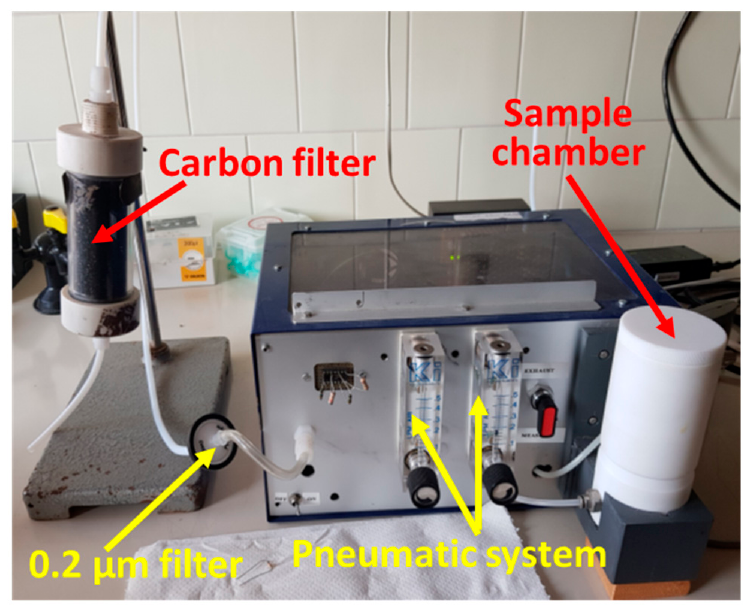
Figure 5. The device and its parts. The case is 30 × 15 × 21 cm 3 (WxHxD).